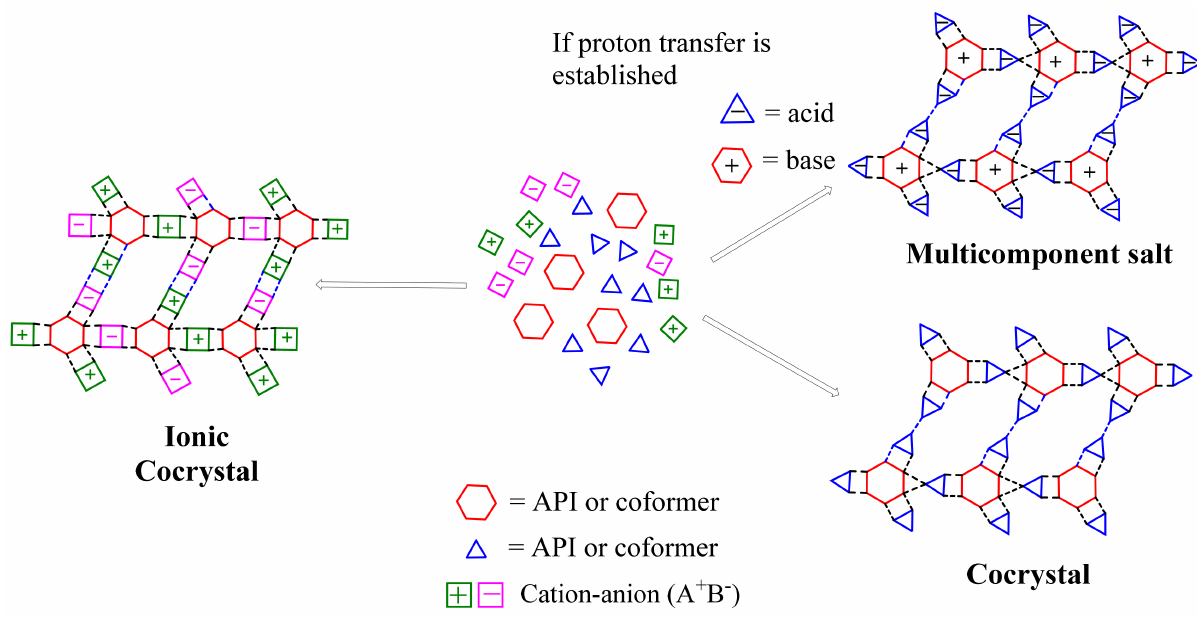
Figure 11. Schematic representation of the formation of multicomponent salt or cocrystal or ionic